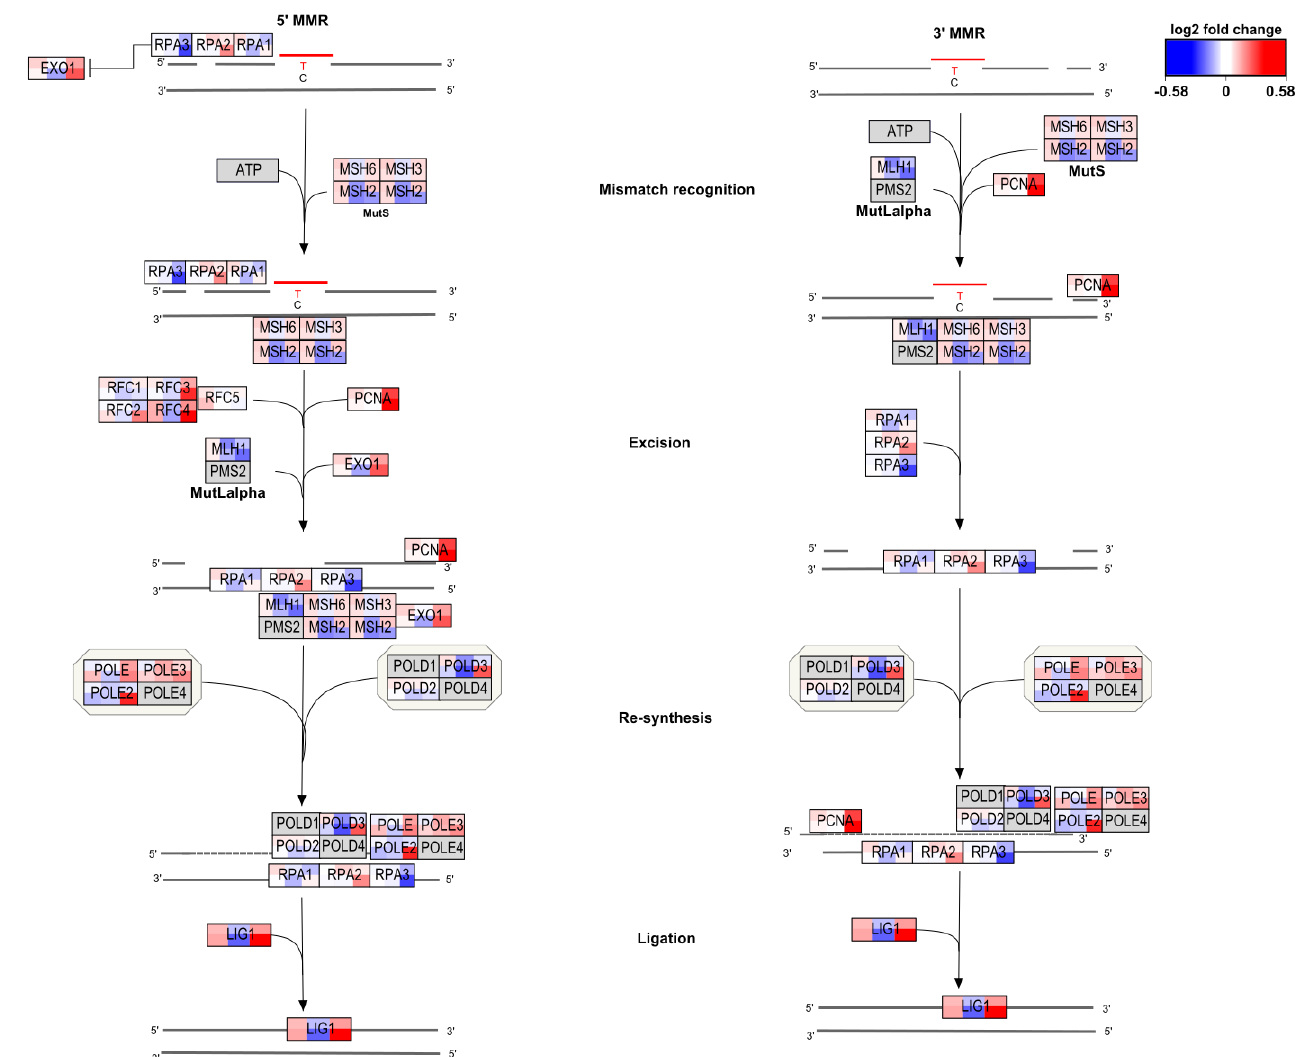
Figure A3. Visualization of log fold change on the DNA Mismatch Repair pathway (wikipathways:WP531) for all six conditions. Cellular models are depicted from left to right as Caco-2/HT29-MTX, SAE, and THP1. The top row depicts the low concentrations whereas the bottom row depicts the high concentrations. Color gradient for differential gene expression after exposure goes from blue (downregulated) via white (not changed) to red